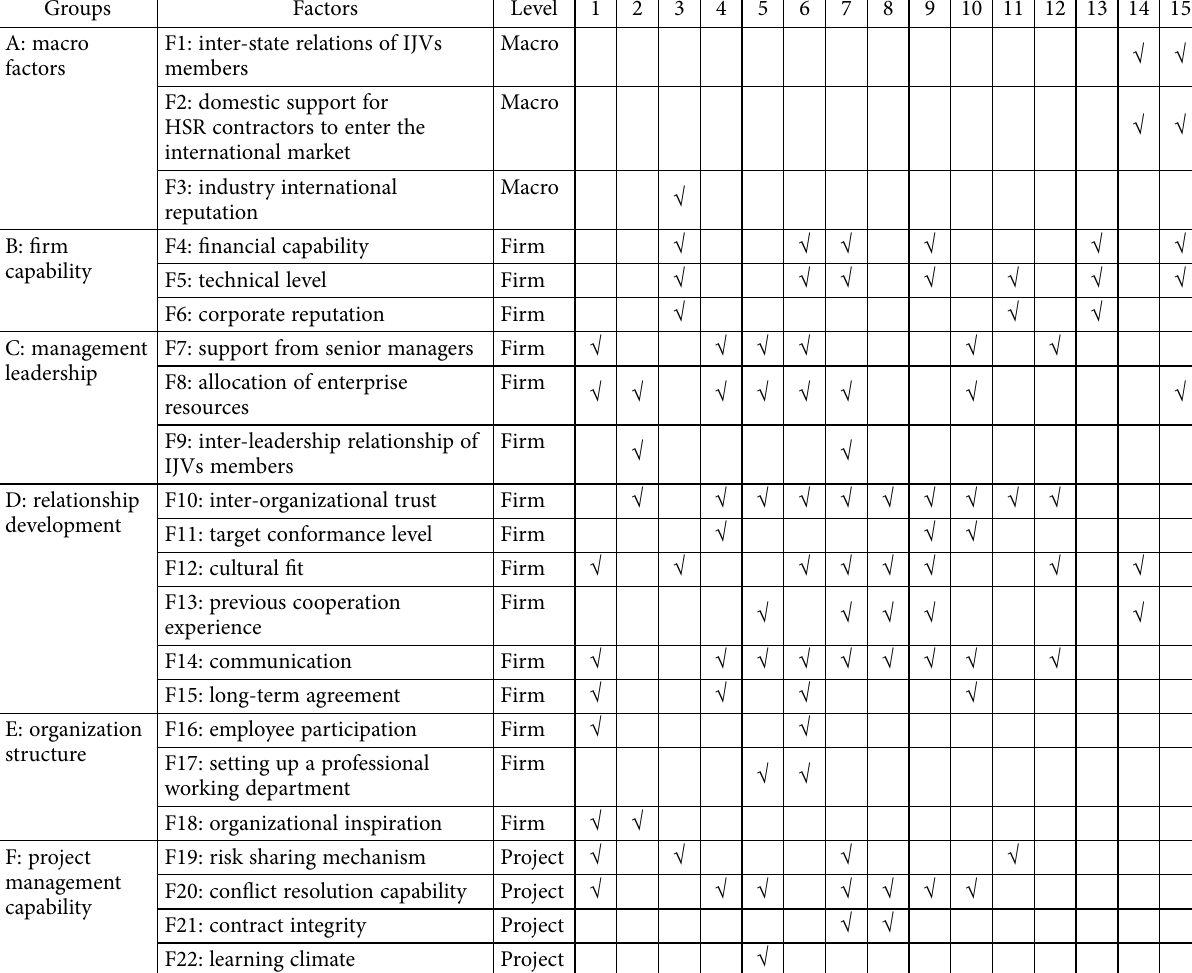
Table 1. Determinants for the coopetition strategies of IJVs in the HSR projects Groups